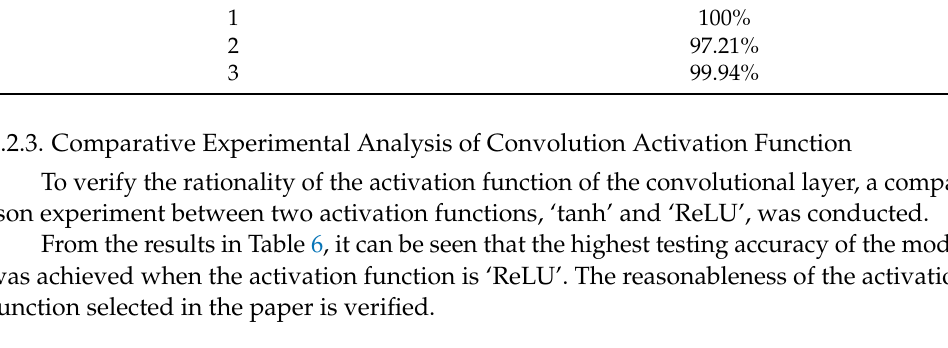
Table 6. Comparative experimental analysis of convolution activation